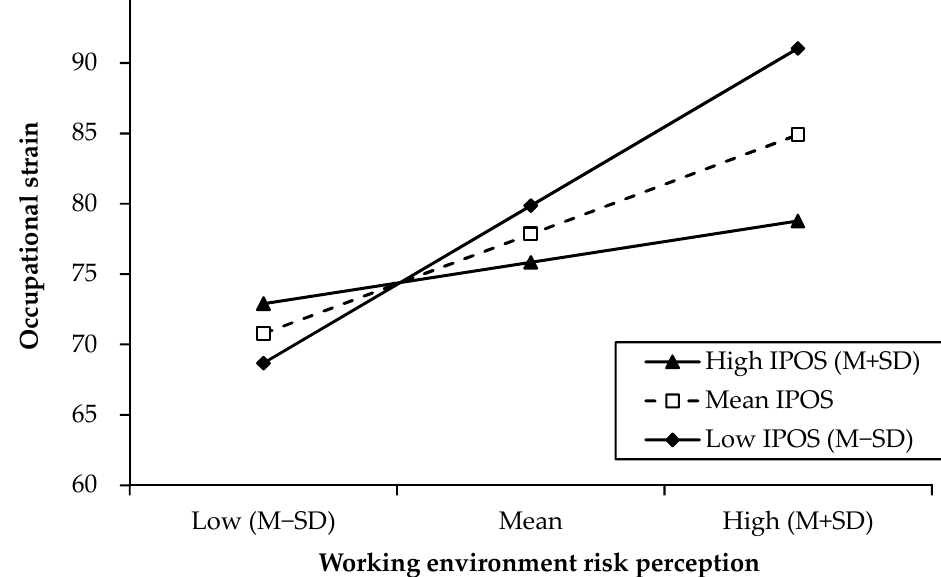
Figure 1. Simple slopes of perceived instrumental support in working environmental risk perception on occupational strain.